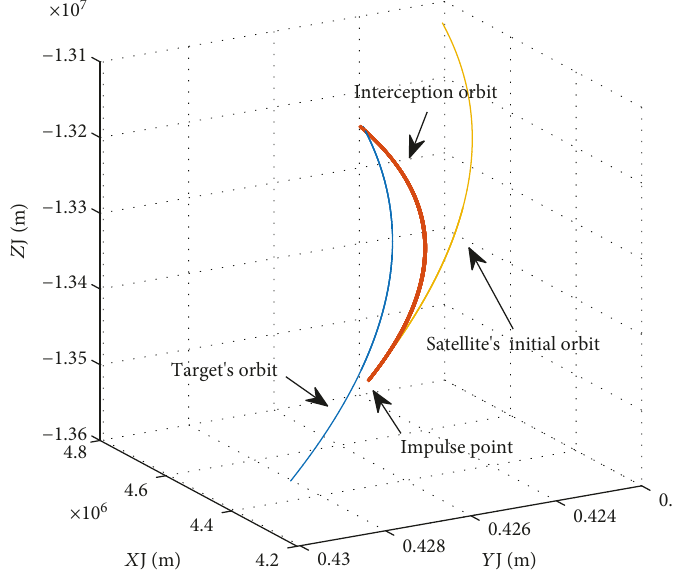
Figure 9: Interception process in the J2000 coordinate